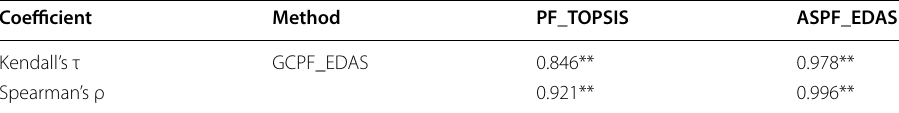
** Correlation is significant at the 0.01 level (2-tailed)